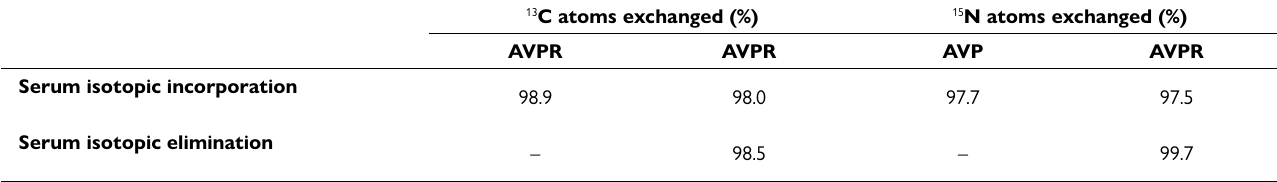
Table 1. Percentages of 13 C and 15 N atoms exchanged during incorporation and elimination of animal protein diet in the AVP and AVPR